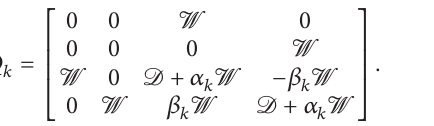
Figure 1: The panels exhibit 𝐸 𝑥 ,𝐸 𝑦 , and 𝐸 regard to 𝑚 𝑥 for 𝑁 = 10 and 𝑚 𝑦 = 0.2 . The bottom one shows that theinnersynchronizationinsidenetwork 𝑋 iseasilyachieved.When ≥ 0.5 , the inner and outer synchronization simultaneously 𝑚 𝑥